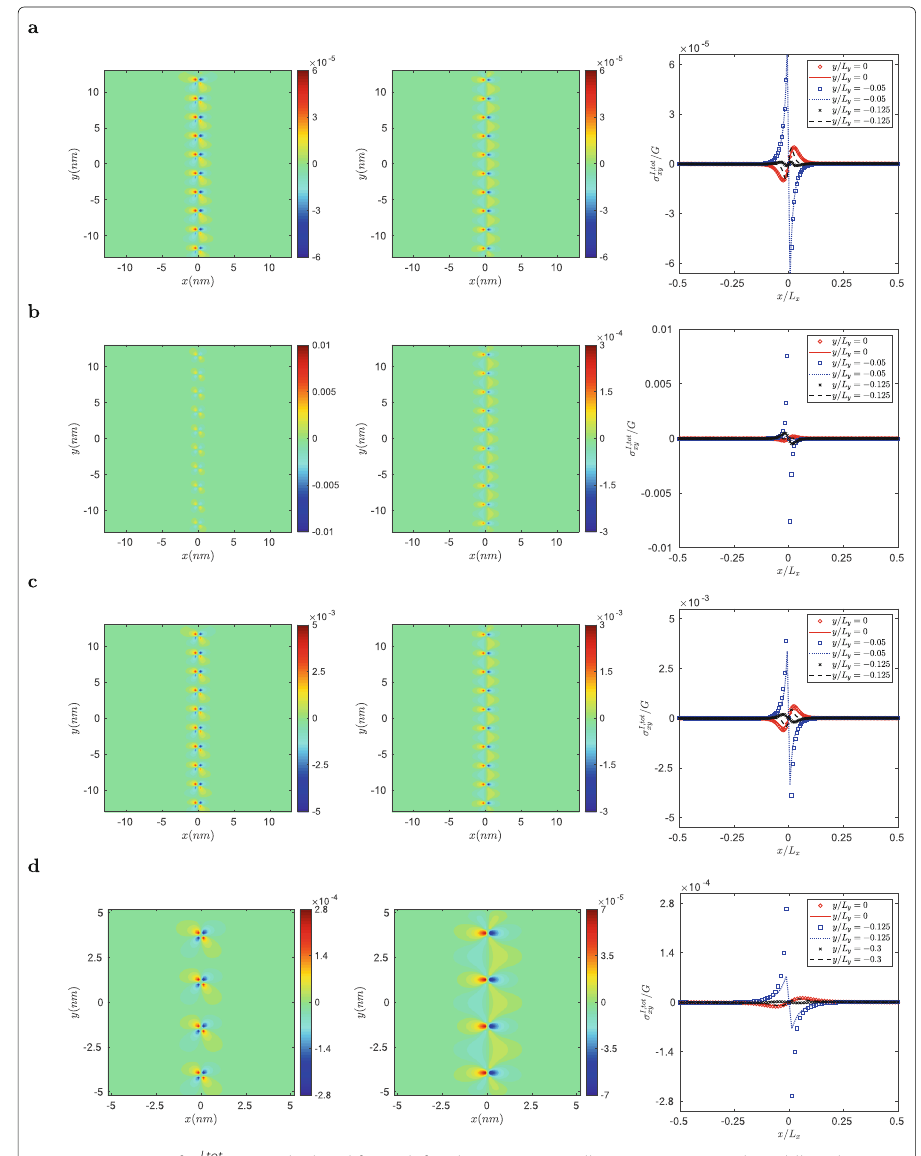
Fig. 8 Contours of σ I , tot xy / G as calculated from: (left column) numerically using Eq. (27) and (middle column) using the linearized solution in Eq. (31). The σ I , tot xy / G along the x -direction at different height as predicted from both solutions is shown in the right column. The simulation parameters are: ( a ) χ 0 = 0.001, L x = L y = 26nm, T = 1200K, ( b ) χ 0 = 0.001, L x = L y = 26nm, T = 300K, ( c ) χ 0 = 0.05, L x = L y = 26nm, T = 1200K, ( d ) χ 0 = 0.001, L x = L y = 10.4nm, T = 1200K. The symbols in the right column are those using Eq. (27), while the lines are those from the linearized solution in Eq. (31)